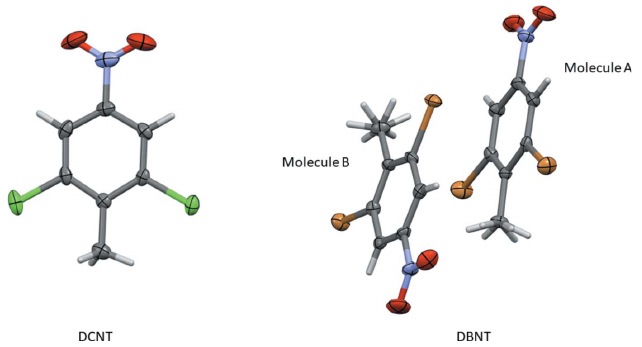
Figure 3 The molecular structures of DCNT and DBNT, with displacement ellipsoids drawn at the 50% probability level.